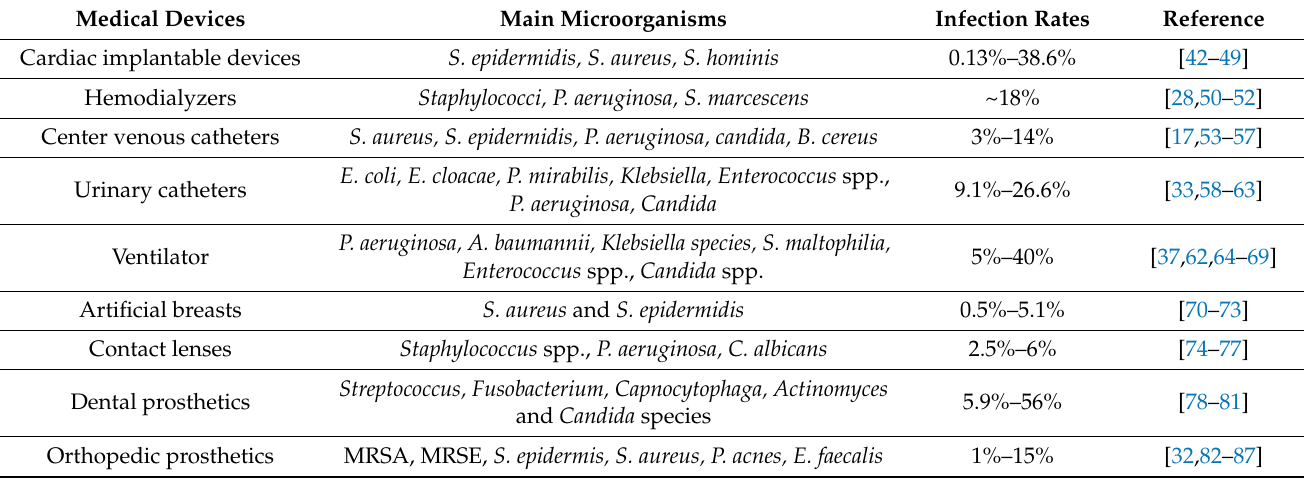
Table 1. The main microorganisms involved in the formation of biofilms and infection rates for different medical devices. Medical Devices Main Microorganisms Infection Rates Reference Cardiac implantable